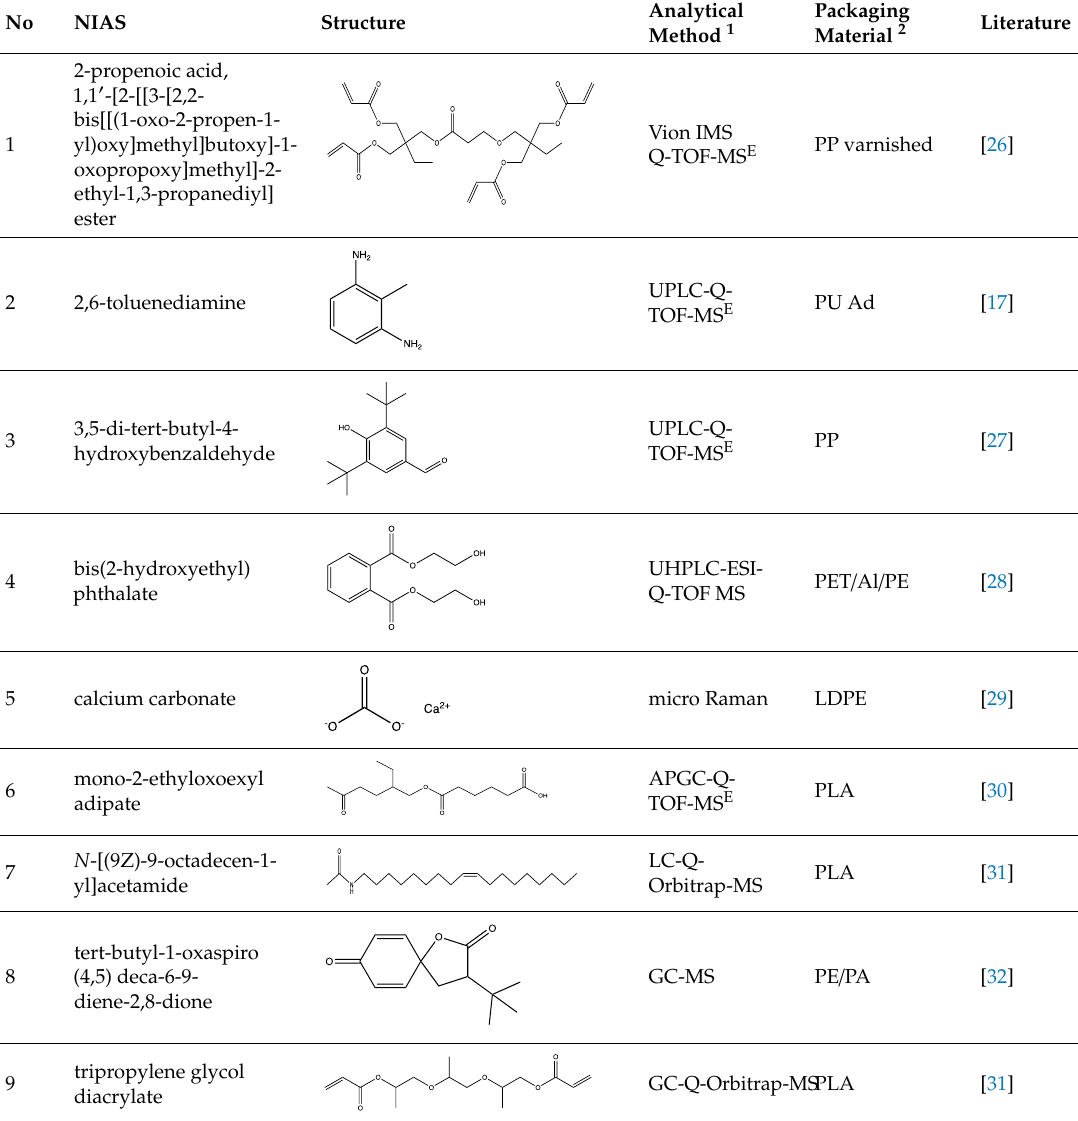
Table 2. Example of NIAS detected in real samples of food packaging.